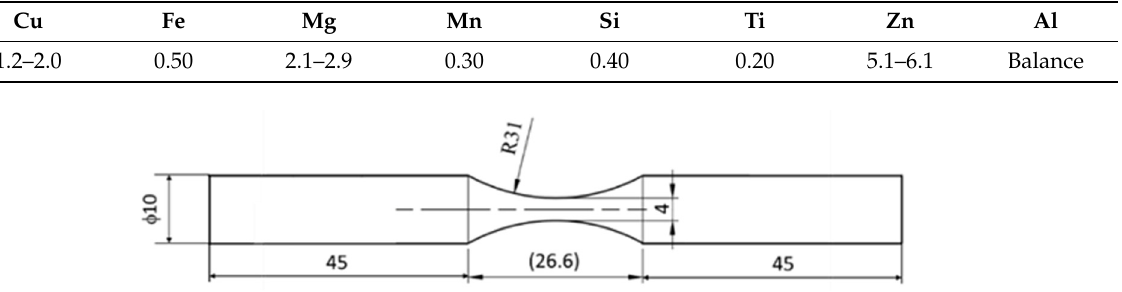
Table 1. Chemical composition of the studied AA7075 alloy (in wt.%).